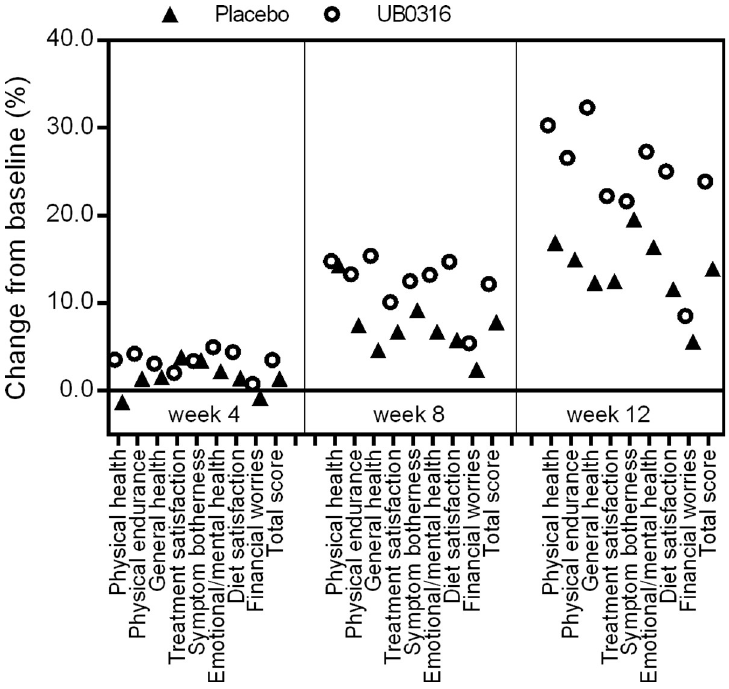
Fig 3. Effect of UB0316 and placebo on quality of life change (%) from baseline value (adjusted to zero) to week 4, 8 and 12. The percent change was calculated as, Mean week − Mean baseline / Mean baseline × 100.